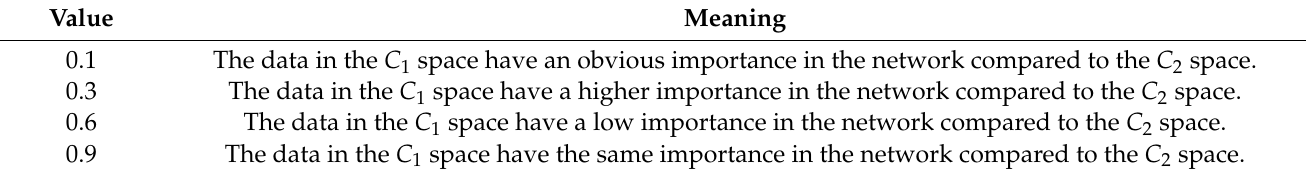
Table 1. Meaning of the scale from 0.1 to